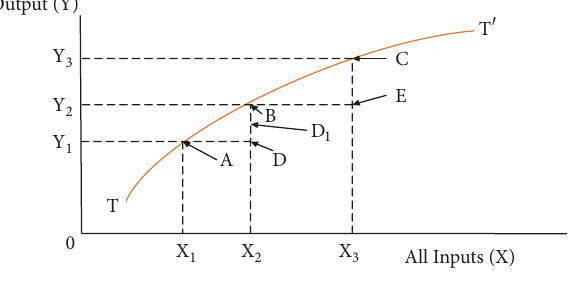
Figure 1: Production